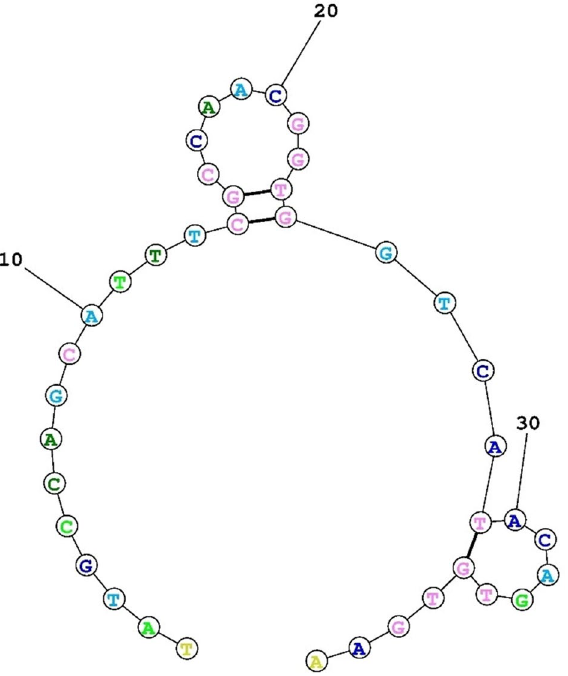
Figure 2. The secondary structure of the deoxyribonucleic acid-aptamer specific to P. gingivalis